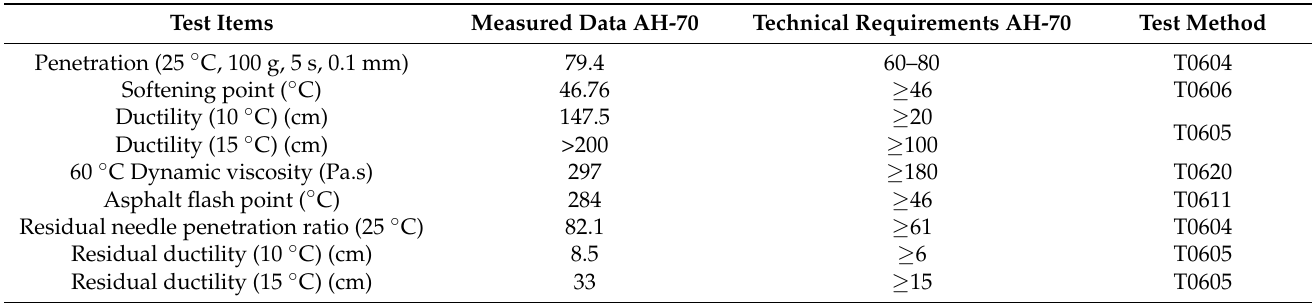
Table 1. Test results of asphalt raw